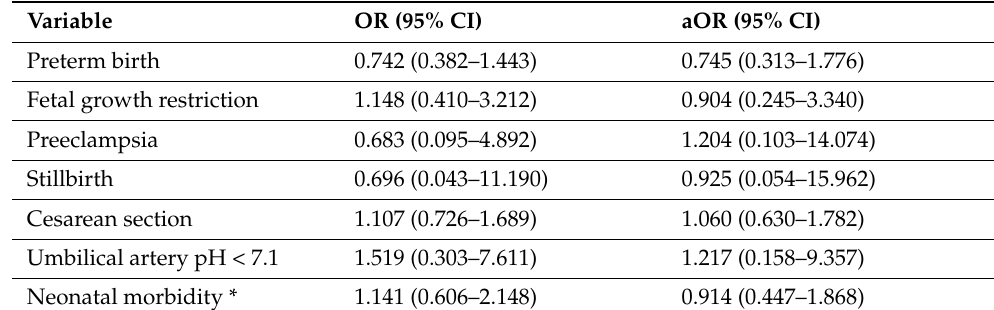
Table 3. Odds ratios (ORs), adjusted odds ratios (aORs), and 95% confidence intervals (CIs) for perinatal outcomes among the symptomatic and asymptomatic pregnant patients with SARS-CoV-2